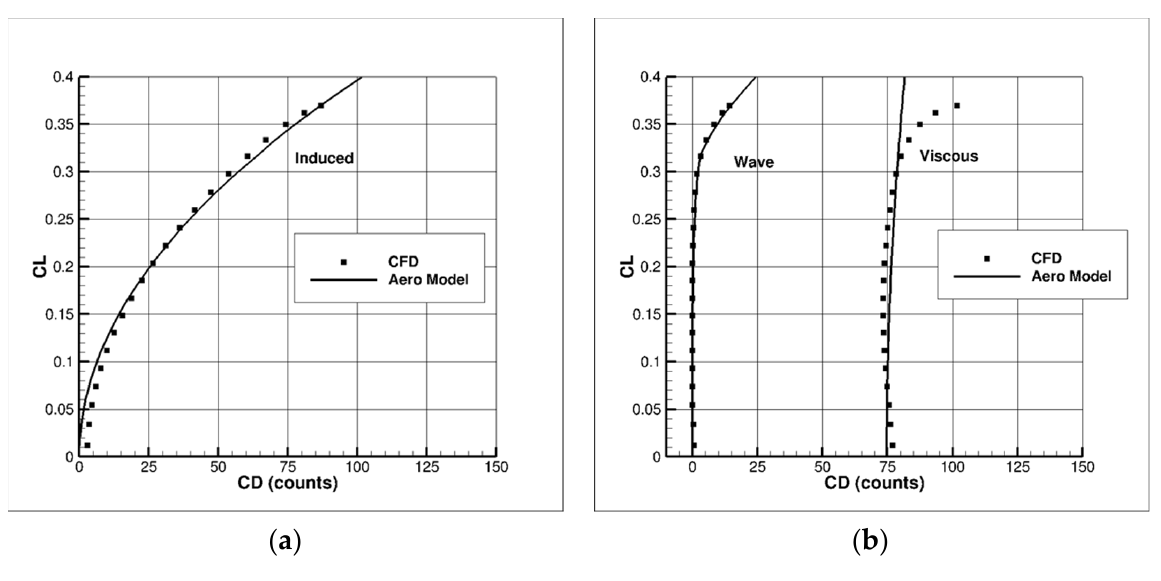
Figure 34. SMILE BWB configuration—drag components. Lines—aerodynamic module; symbols—CFD. ( a ) Lift-induced. ( b ) Wave and viscous.